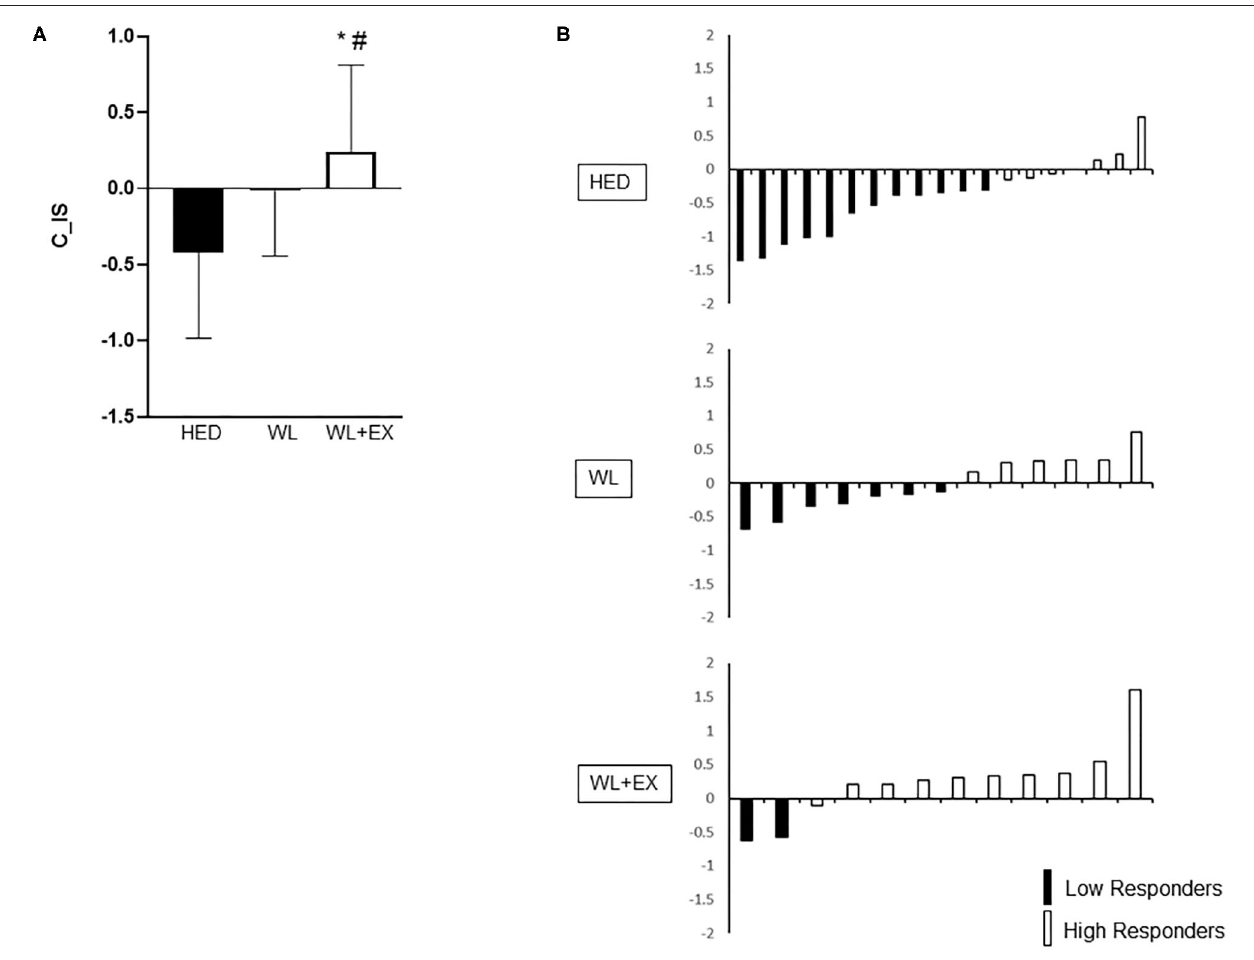
FIGURE 1 | Group differences [ (A) ; mean C_IS and SD] and heterogeneity in individual response (B) for C_IS. *Significantly different from HED; # Significantly different from WL.